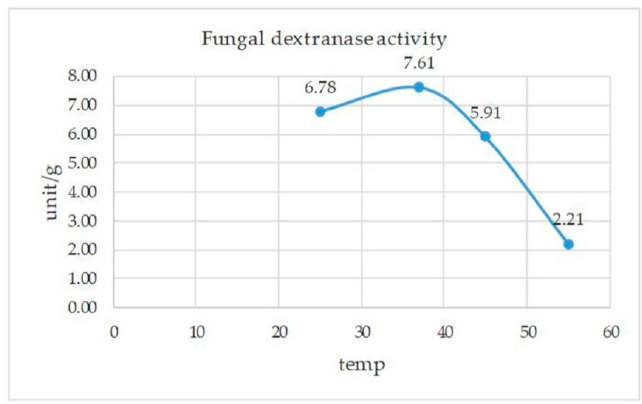
Molecules 2020 , 25 , x FOR PEER REVIEW Figure A1. The suitable condition of fungal dextranase activity was 7.61 unit / g at pH of 6 and 37 ◦ C. Figure A1. The suitable condition of fungal dextranase activity was 7 . 61 unit / g at pH of 6 and 37 °C.